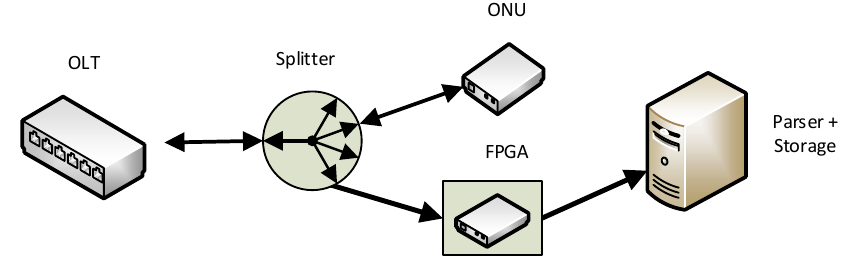
Figure 1. Scheme of our measurement